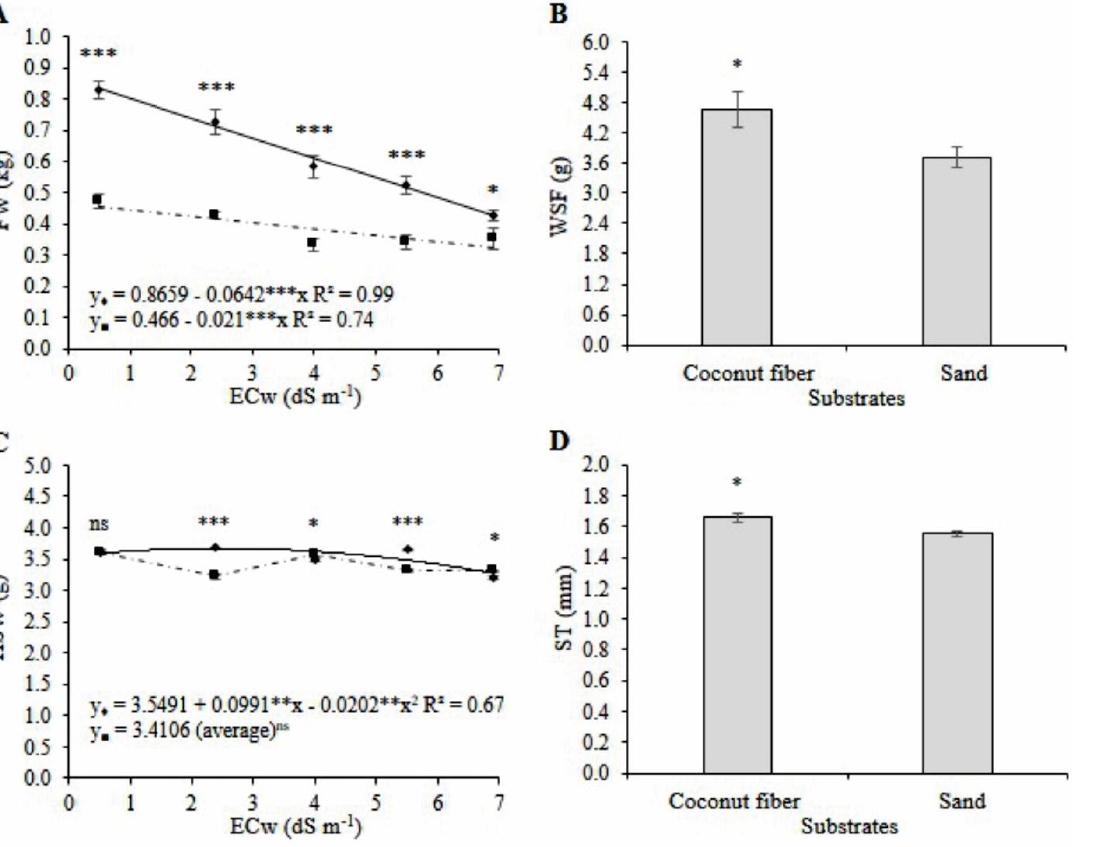
Figure 4. Regression analysis and means comparison test (Tukey, p < 0.05 and SD, n = 20) for the variables fruit weight–FW ( A ), the weight of seeds per fruit–WSF ( B ), hundred-seed weight–HSW ( C ), and seed thickness –ST ( D ) of mini watermelon in hydroponic cultivation using a nutrient solution prepared with reject brine and different substrates ( ♦ Coconut fiber; ■ Sand). ***, **, *, and ns significant at 0.001, 0.01, 0.05 probability levels, and not significant, respectively.